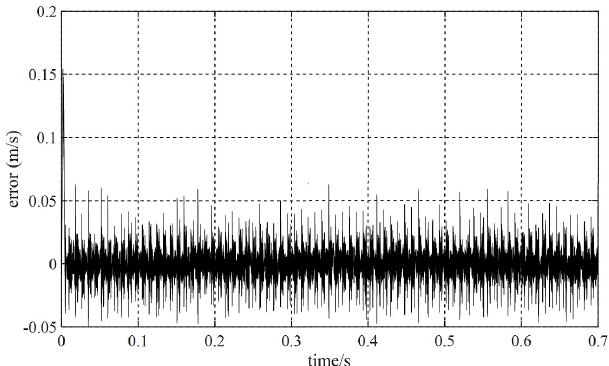
Figure 20. The velocity tracking error of the sliding-mode observer